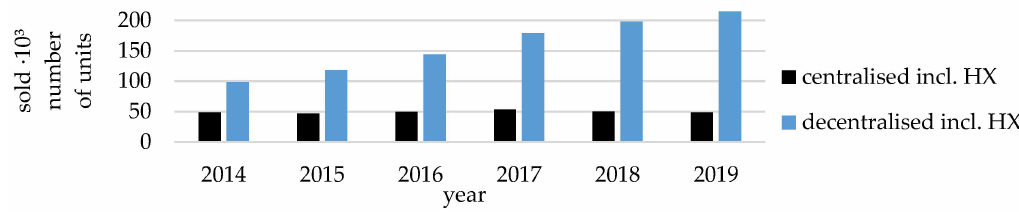
Figure 1. Market development of ventilation systems in Germany; HX = heat exchanger [1–4].